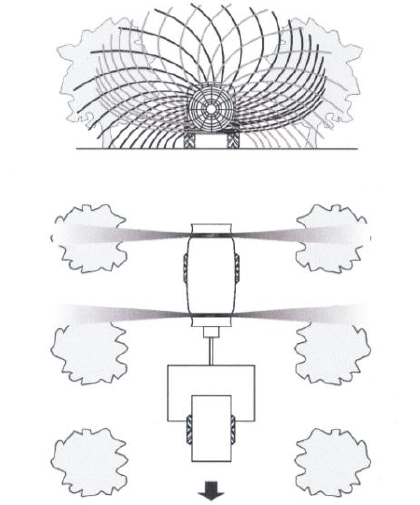
Figure 2. Air flow produced by the front and back fans.